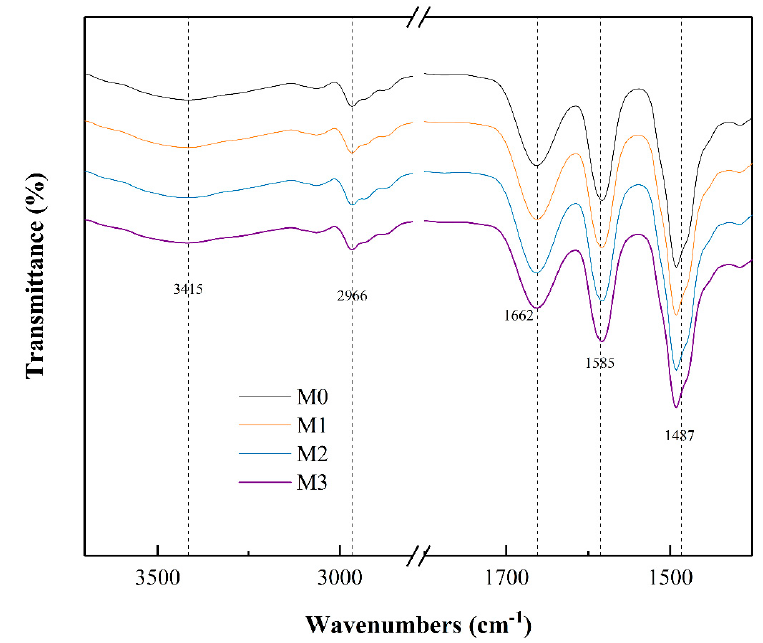
Figure 5. Fourier transform infrared spectroscopy (FTIR) spectra of the prepared membranes.